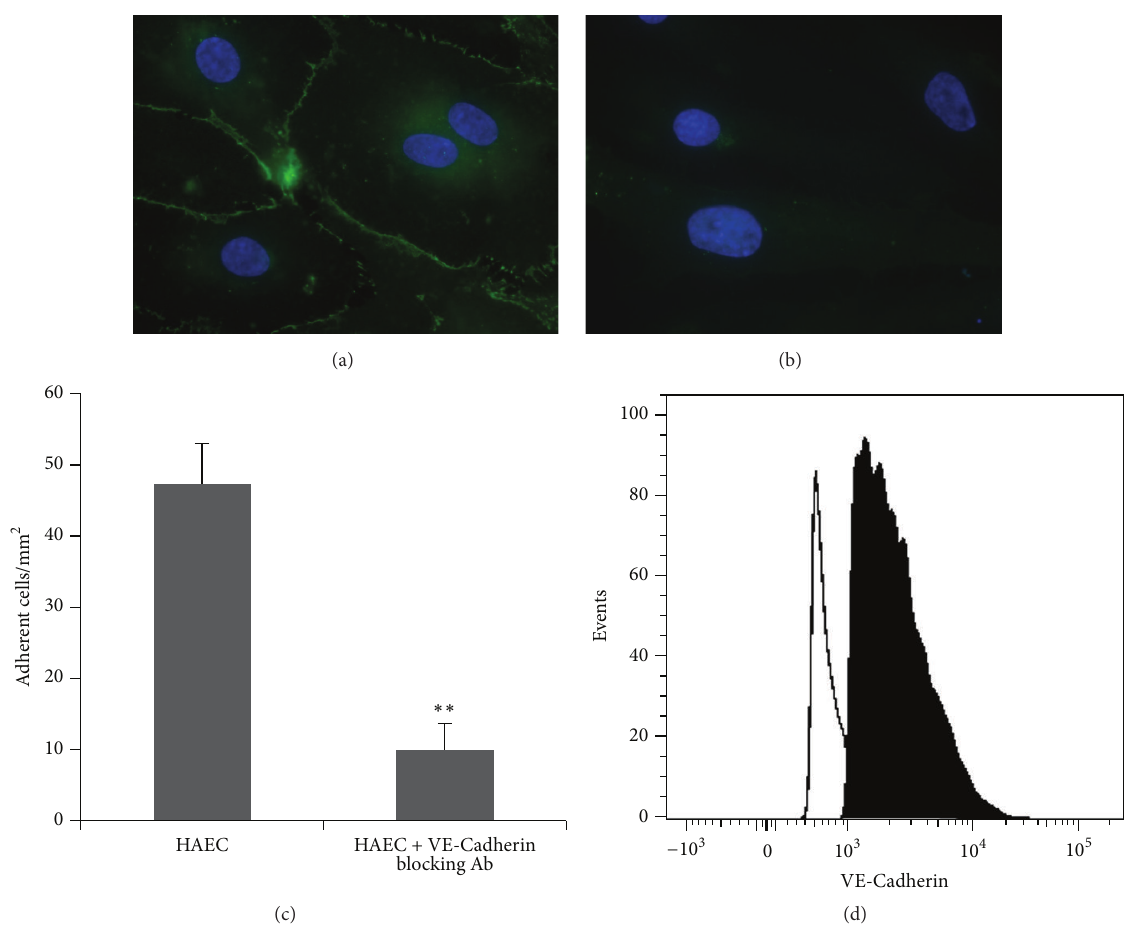
Figure 3: Representative microscopic images of VE-Cadherin expression in control HAEC (a) and HAEC incubated with anti-VE-Cadherin antibody for 1 hour at 37 ∘ C (b). Scale bar 20 𝜇 m. Effect of VE-Cadherin on dynamic interaction of LO-EPC with HAEC. 4 × 10 5 LO-EPC were perfused (c). The data was represented as mean ± SE of three experiments. ∗∗ 𝑝 < 0.01 . Representative flow cytometric histograms illustrating VE-Cadherin expression in LO-EPC and HAEC (d). The lined histogram represents VE-Cadherin expression in HAEC and the filled histogram represents VE-Cadherin expression in